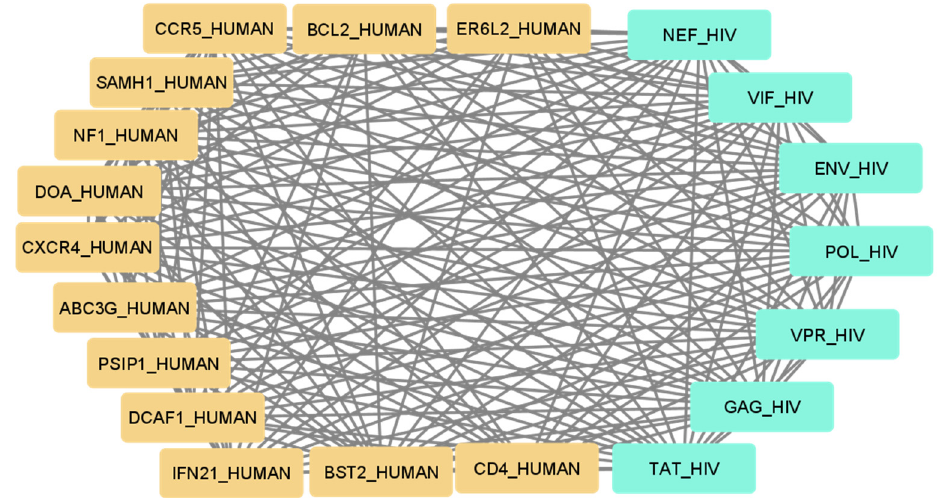
Figure 1. The map of the best-studied human proteins interacting with HIV